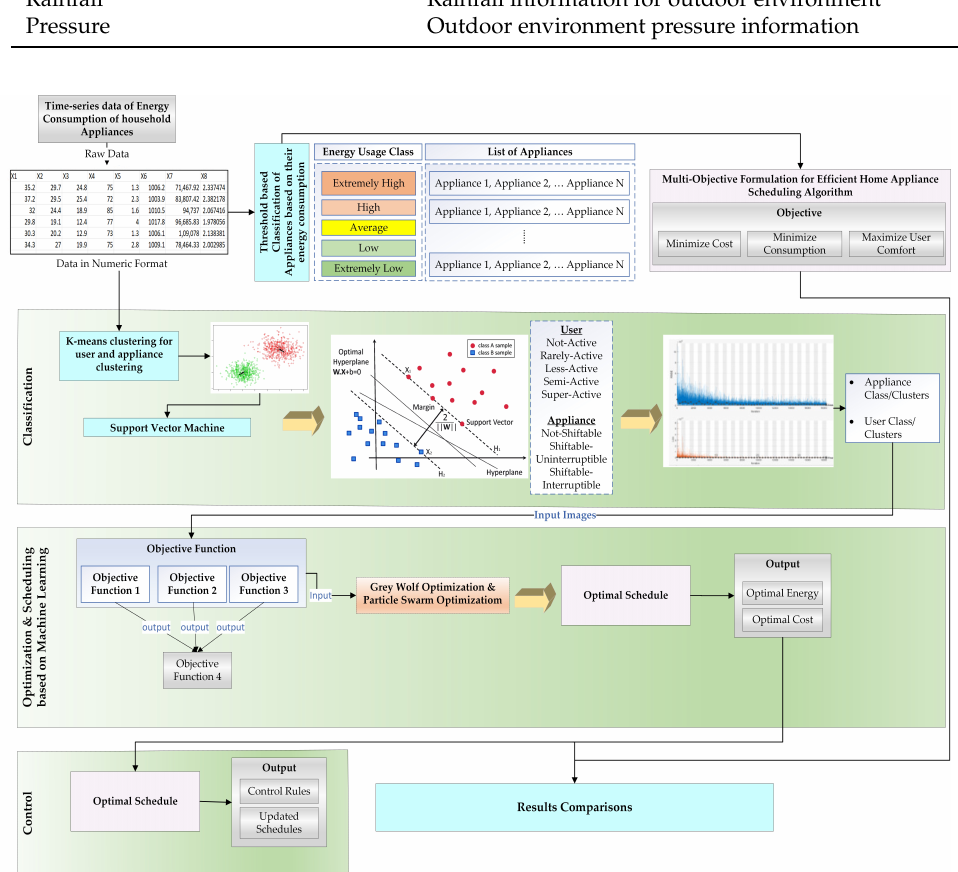
Figure 2. Architectural overview of the proposed